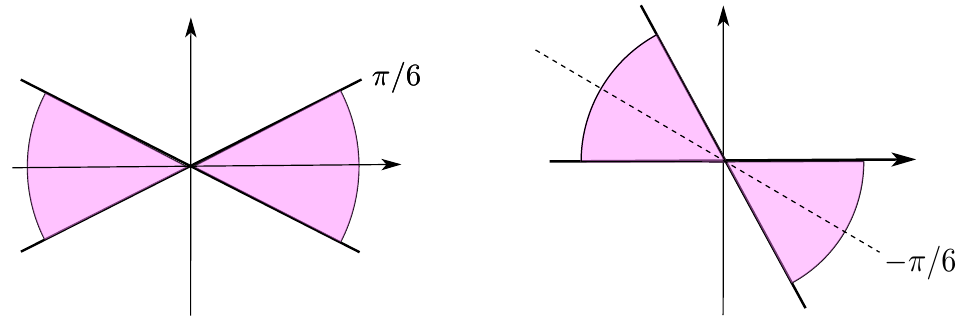
Figure 1 . On the left, we depict the regions in the complex x plane where the eigenfunctions of the quartic oscillator with g > 0 decay at in(cid:12)nity. As g becomes complex, we can de(cid:12)ne a spectral problem by requiring that the eigenfunctions decay at in(cid:12)nity in the rotated wedges (2.5) of the complex plane. The (cid:12)gure on the right shows the relevant wedges for g < 0. symmetric but it is not essentially self-adjoint (see e.g. [21]). One can however de(cid:12)ne